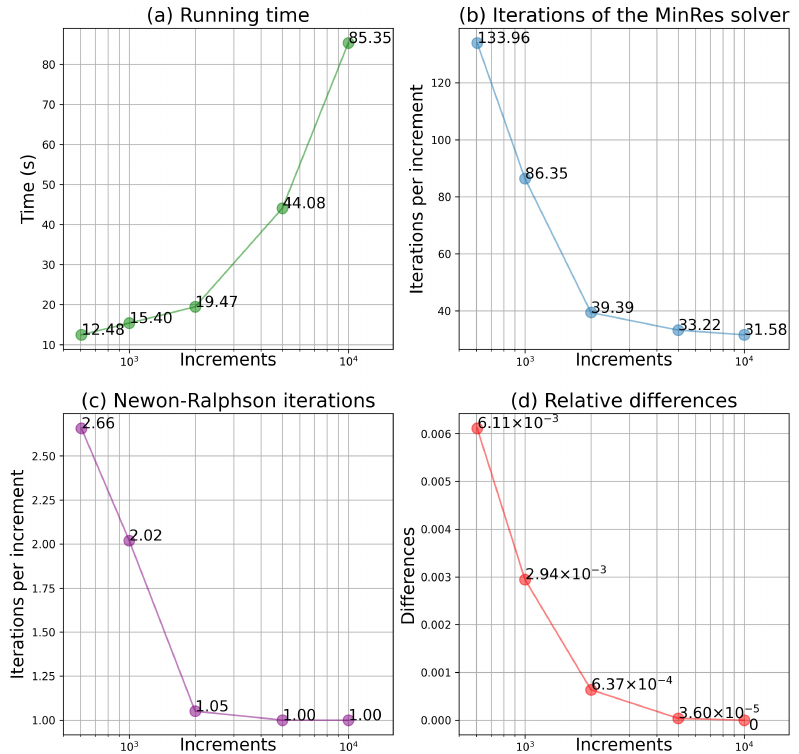
Figure 3. Performances of the single-point calculator as functions of the total number of increments for the simulation (presented in Section 3.1.2) with the single crystal plasticity model. The MinRes solver is chosen. The initial guess is the zero vector; the acceptable error is 1 × 10 − 8 ; the maximum number of iterations is